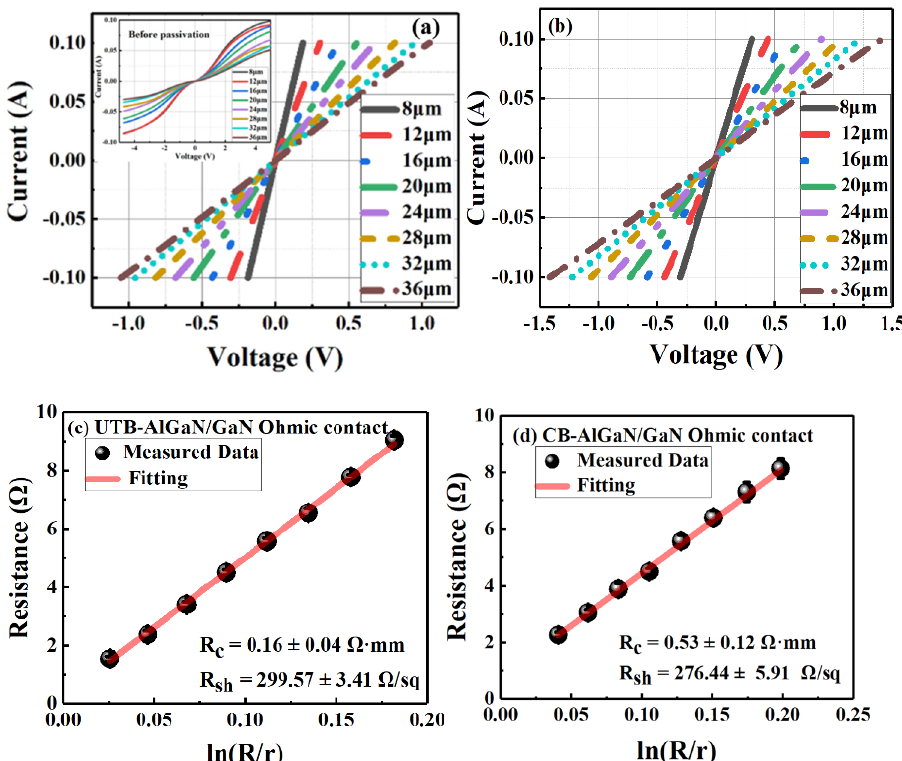
Figure 2. I–V characteristics of ohmic contacts to ( a ) UTB − AlGaN/GaN heterostructure and ( b ) CB − AlGaN/GaN heterostructure. Evolution of ohmic resistances with ohmic-contact spacing in samples with ( c ) UTB − AlGaN/GaN heterostructure and ( d ) CB − AlGaN/GaN heterostructure. The TFE fitting produces a Φ B of 0.45 eV and an N D of 1.59 × 10 19 cm − 3 for the CB heterostructure, as opposed to values of 0.61 eV and 1.10 × 10 20 cm –3 obtained in the UTB ones. Similar orders of magnitude of N D (~10 19 cm − 3 ) and Ф B (0.5 eV) have also been re-